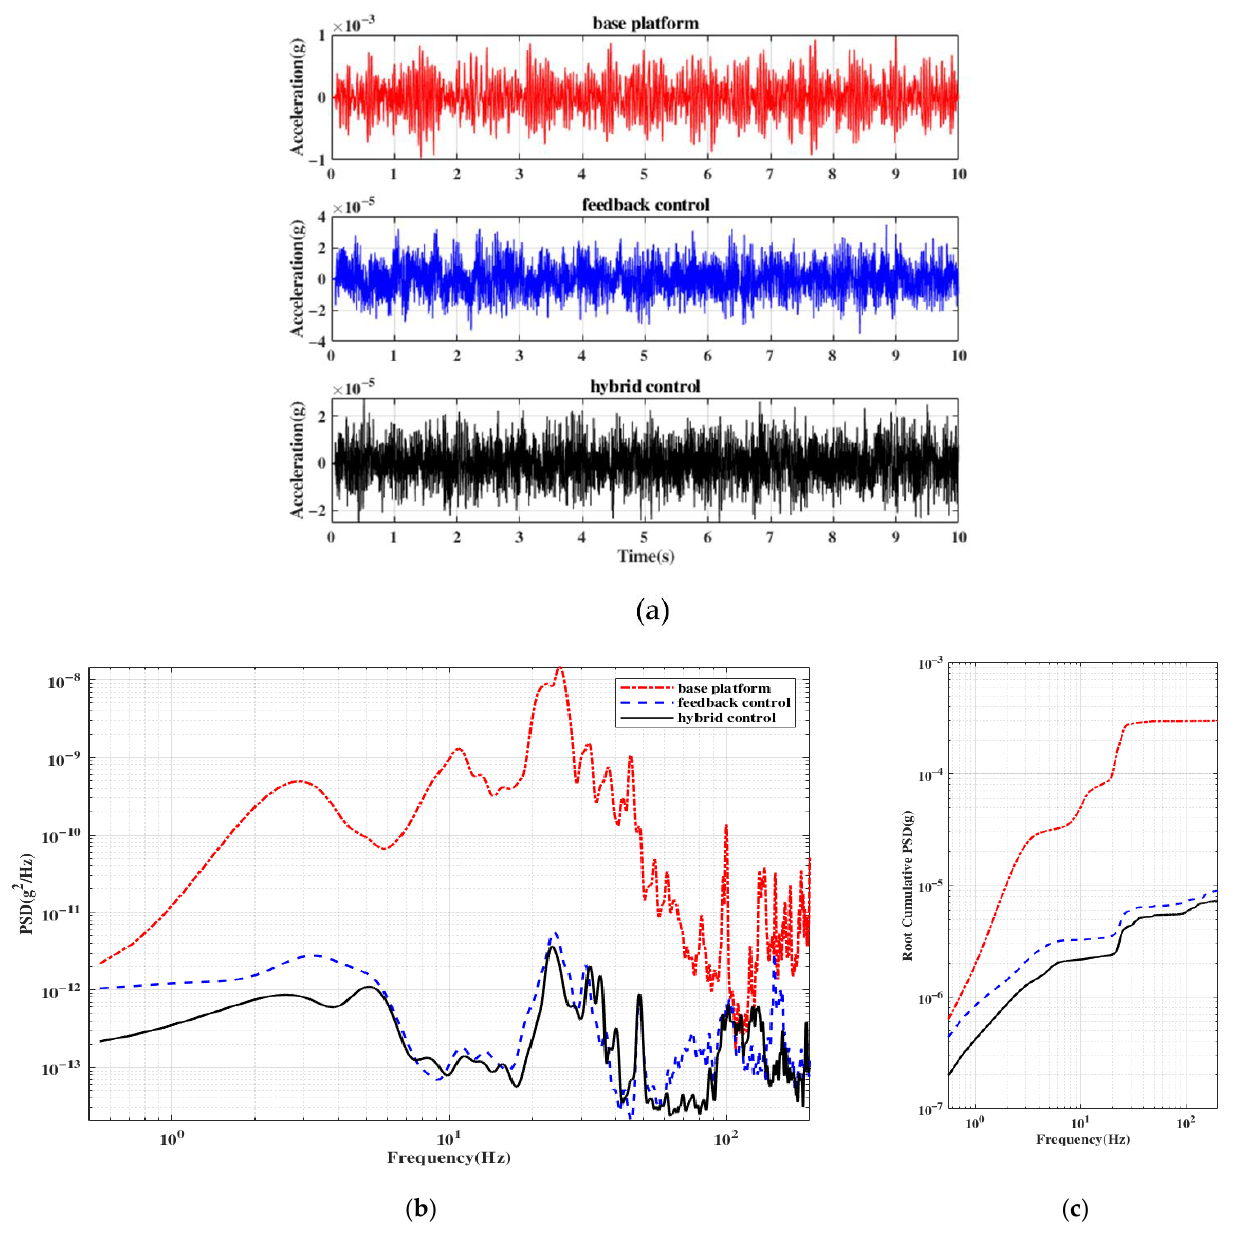
Figure 10. The performance of active vibration isolation with feedback and hybrid control in Z- axis. ( a ) Time domain; ( b ) Measured PSD; ( c ) Measured root cumulative PSD.